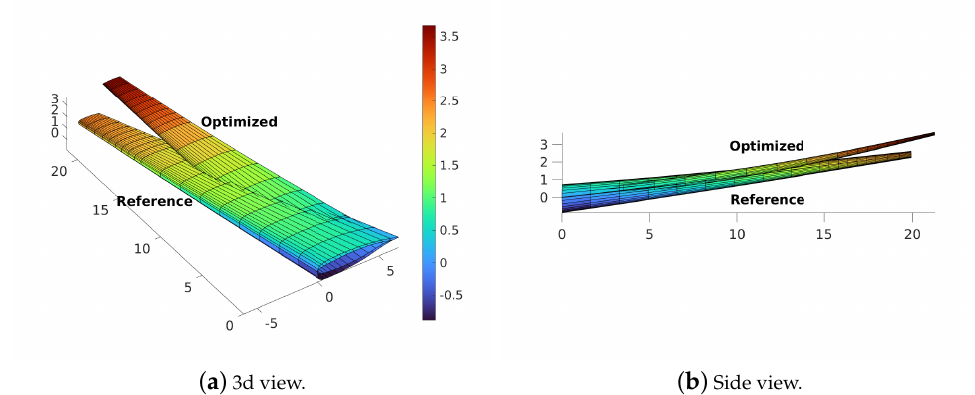
Figure 18. Forward-swept wing aircraft aeroelastic deformation at cruise. Similarly, the backward-swept case can be visualised in Figure